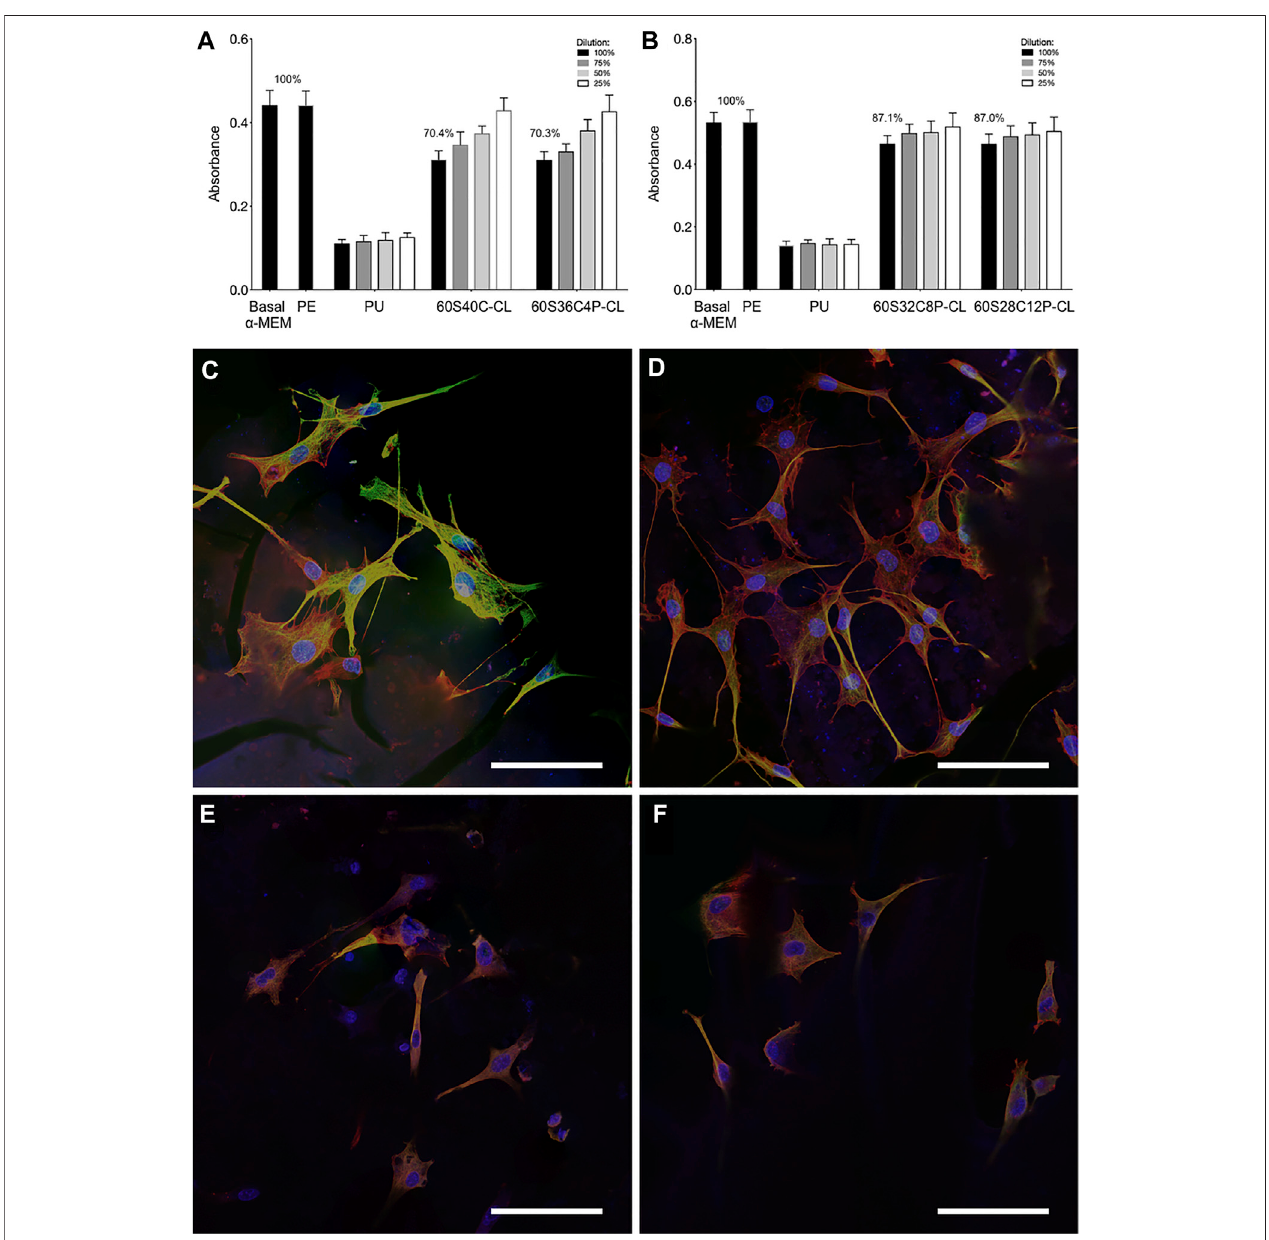
FIGURE8| Preosteoblastcellcultures followingexposuretodissolutionproducts ofthehybrids and cultureon thesurfaceofmonoliths: (A,B) Metabolicactivity of the preosteoblast cells after 24 h of incubation with the dissolution products of each of the four Ca-containing hybrids (C – F) confocal microscopy images of the preosteoblast cells cultured on the surface of (C) 60S40C-CL, (D) 60S36C4P-CL, (E) 60S32C8P-CL, (F) 60S28C12P-CL. Scale bars = 100 μ m in (C – F) . Data points are mean ± S.D. Statistical analysis was performed using Kruskal – Wallis test with Dunn ’ s post test in Prism 7. Results were deemed signi fi cant if the probability of occurrence by random chance alone was less than 5% (i.e., p <